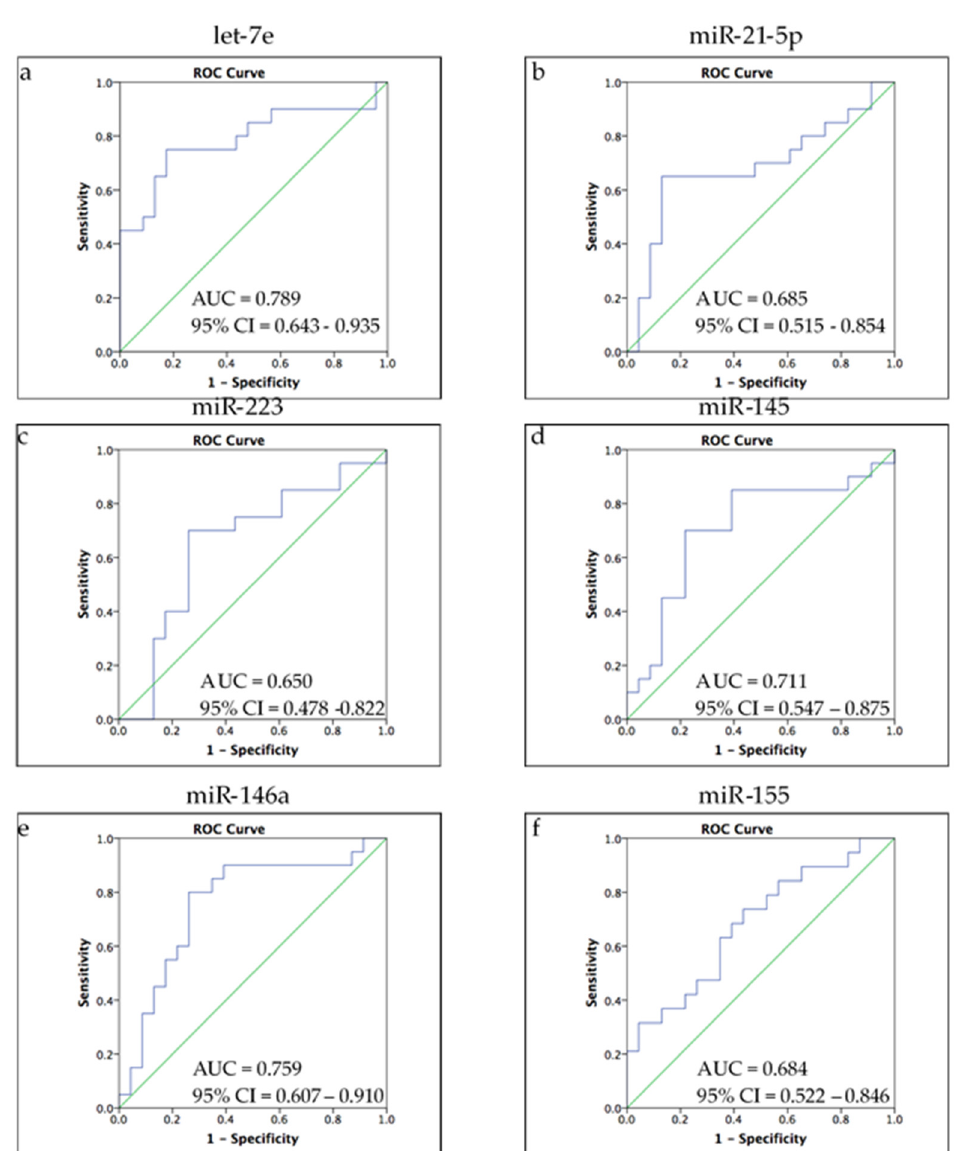
Figure 2. ROC analysis of ability of microRNAs to discriminate remission from non-remission. ( a ) let-7e; ( b ) miR-21-5p; ( c ) miR-223 ( d ) miR-145; ( e ) miR-146a; ( f ) miR-155. ( a, d, e ) let-7e, miR-145, and miR-146a showed acceptable discrimination (0.7 ≥ AUC > 0.6) between remission and non-remission ( b, f ) miR-21-5p and miR-155 showed poor discrimination (0.6 ≥ AUC > 0.5). ( c ) miR-223 showed no discrimination.